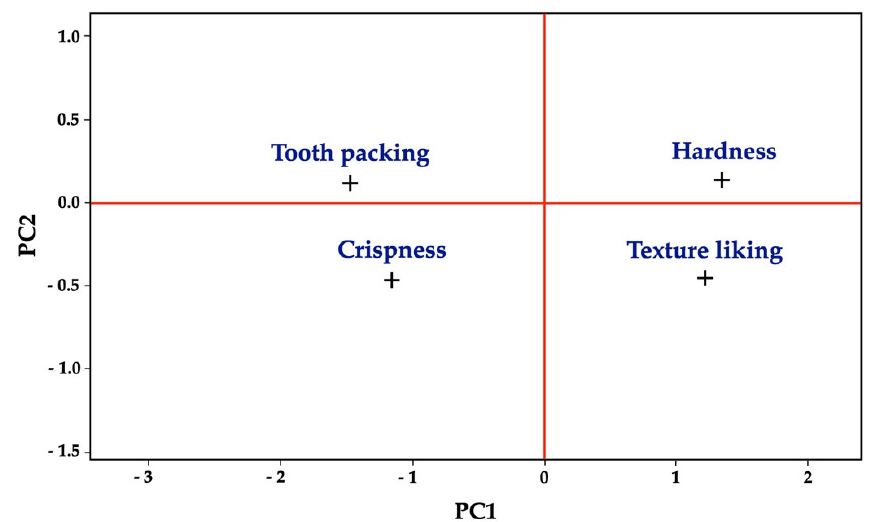
Figure 10. Loading plot of five sensory attributes on principal component axes. The 1st (PC1) and the 2nd (PC2) axes accounted for 65.2% and 16.7% of the total variance, respectively. Table 6. Pearson correlation coefficient (r) between sensory attribute scores of extruded snacks. Texture Liking Crispness Hardness Tooth Packing Texture liking 1.000 Crispness − 0.372 1.000 Hardness 0.409 − 0.501 1.000 Tooth packing − 0.646 * 0.476 − 0.772 * 1.000 * p < 0.05. n =